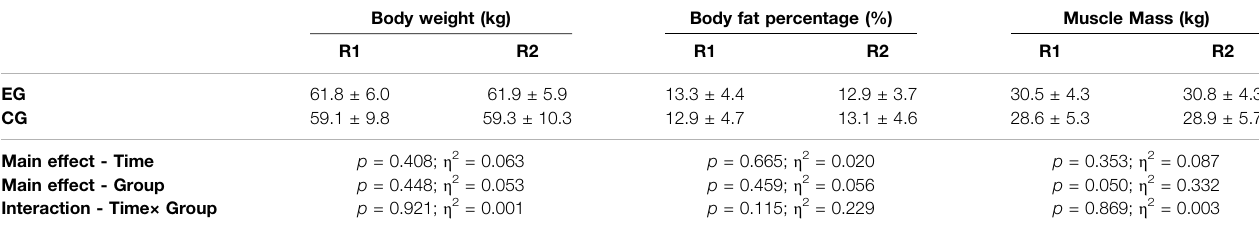
TABLE 1 | Effects of tangeretin intervention on body composition.